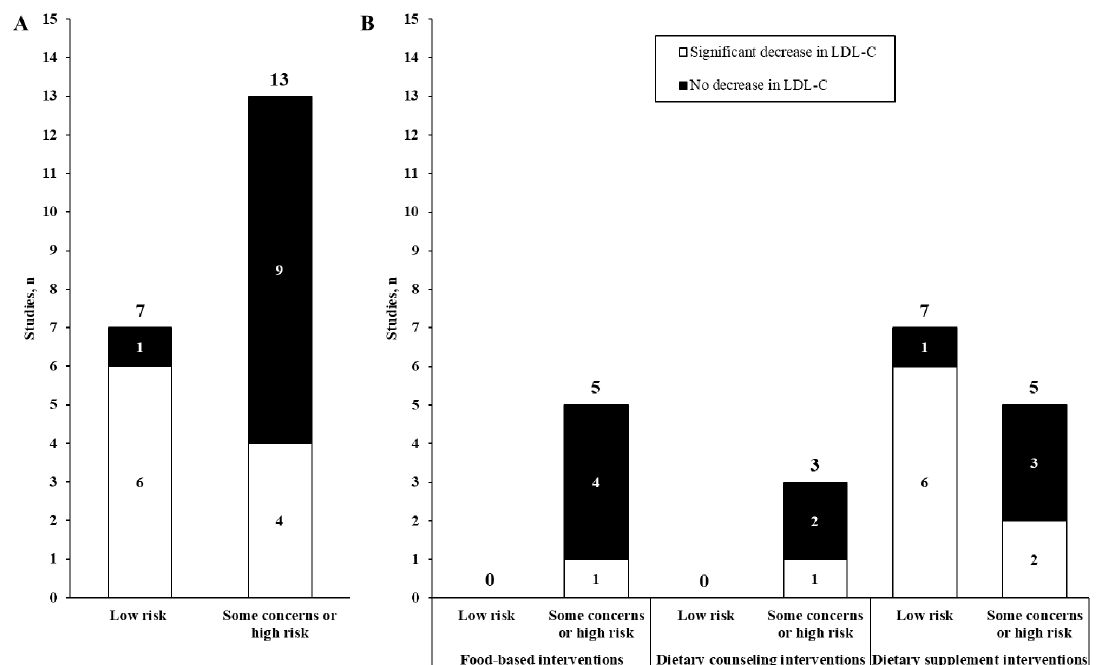
Figure 2. Distribution of the included studies according to their risk of bias (panel ( A )), their design (panel ( B )) and the reported effect on LDL-cholesterol (LDL-C) concentrations. The vertical bars represent the count of studies and the color denotes the reported effect on LDL-cholesterol (black: no decrease; white: significant decrease). In panel A, the chi-square statistic for the likelihood of reporting a significant reduction in LDL-cholesterol was 5.49 ( p = 0.02).